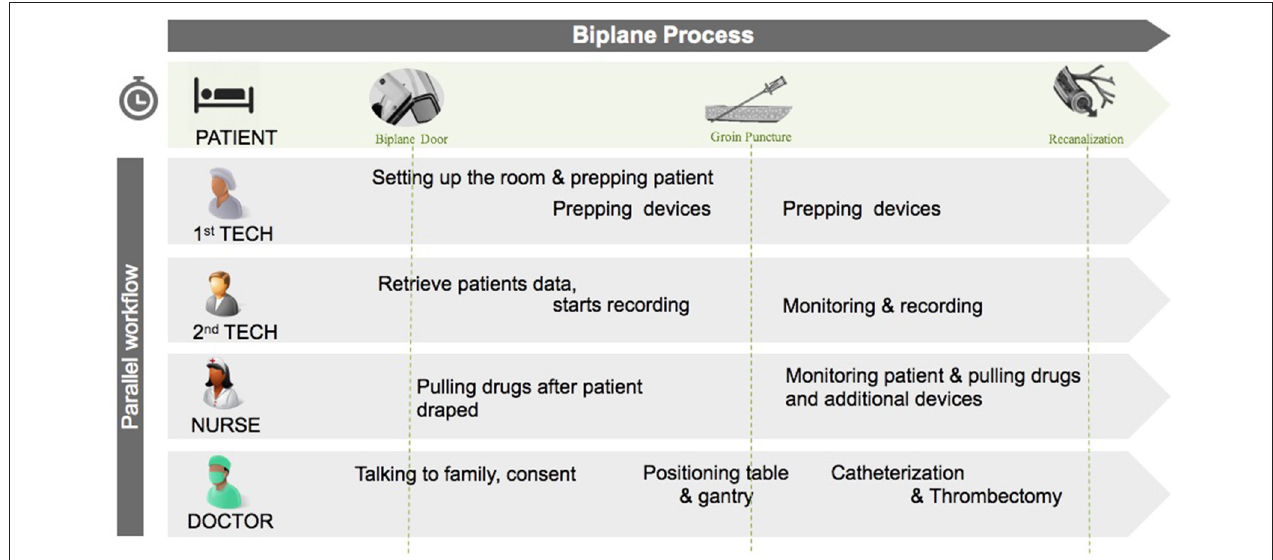
FIGURE 1 | Workflow in the biplane suite illustrating the parallel nature of tasks by the different actors in the room. The “interventional time” starts when the patient arrives in the biplane suite. Tech,